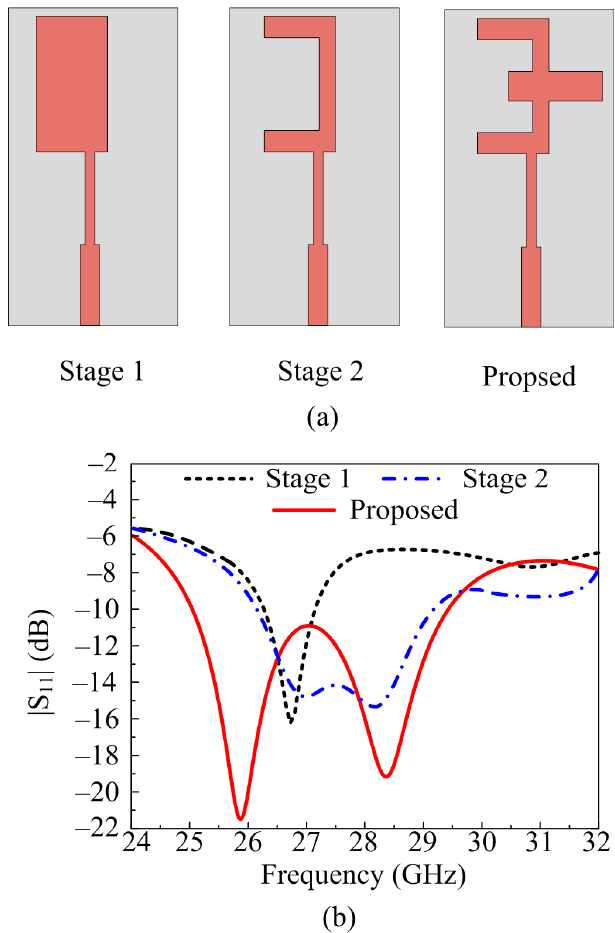
Figure 2. Antenna design steps ( a ) geometrical configuration ( b ) return loss. A x = 12; A y = 8.5; A 1 = 3.7; A 2 = 2.3; A 3 = 3; A 4 = 3.5; A 5 = 3.5; g 1 = 1; g 2 = 0.5; g 3 = 0.6; g 4 = 0.5; g 4 = 0.5; H = 0.79. (All units are in